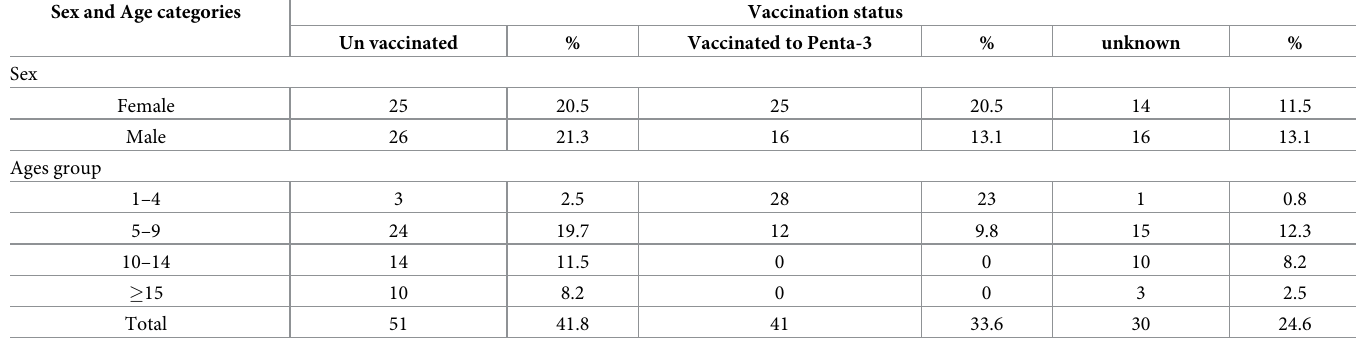
Table 2. Vaccination status of pertussis cases in the Azila cluster of Dahena district, Wag Hemra Zone, Amhara region Ethiopia, 2019. Sex and Age categories